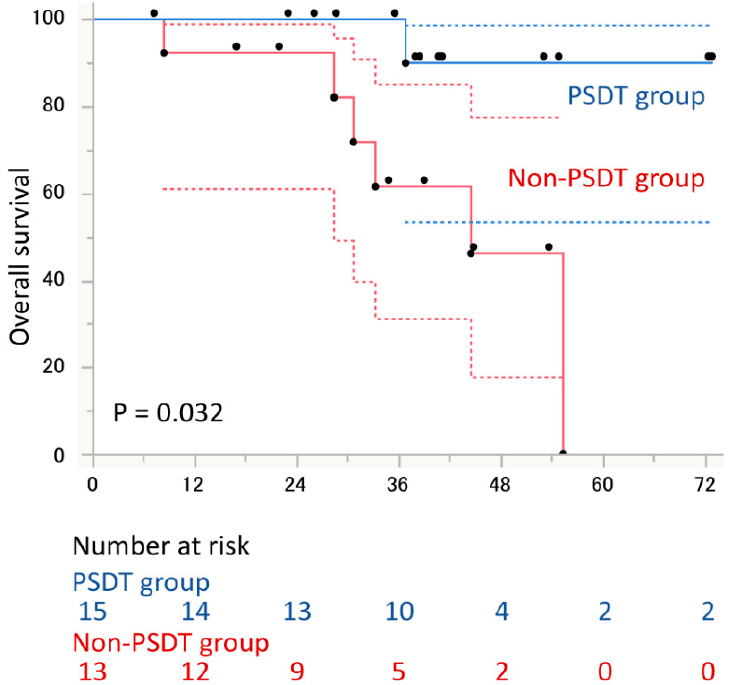
Figure 4. Overall survival from the diagnosis of oligometastatic castration-resistant prostate cancer (OM-CRPC) stratified by performance of progressive site-directed therapy (PSDT). The 95% intervals calculated for each time point are shown as dashed lines. Table 2. Cox hazard model to identify factors predictive of time to PSA progression for an androgen receptor-axis-targeted drug.